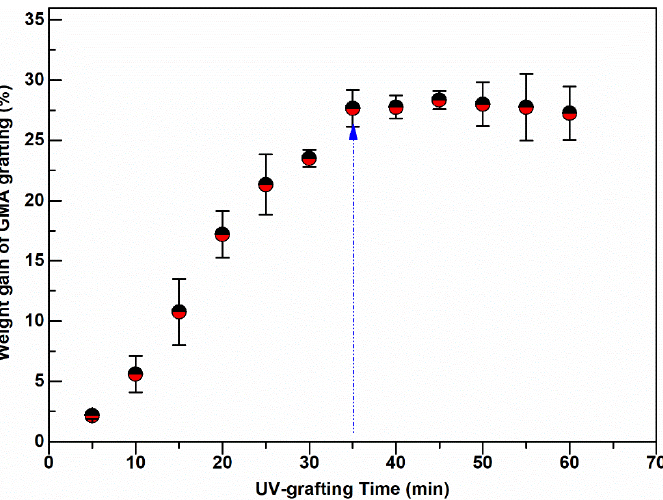
Figure 2. Weight gain of UV-grafted PBT nonwoven membranes at various exposure times.